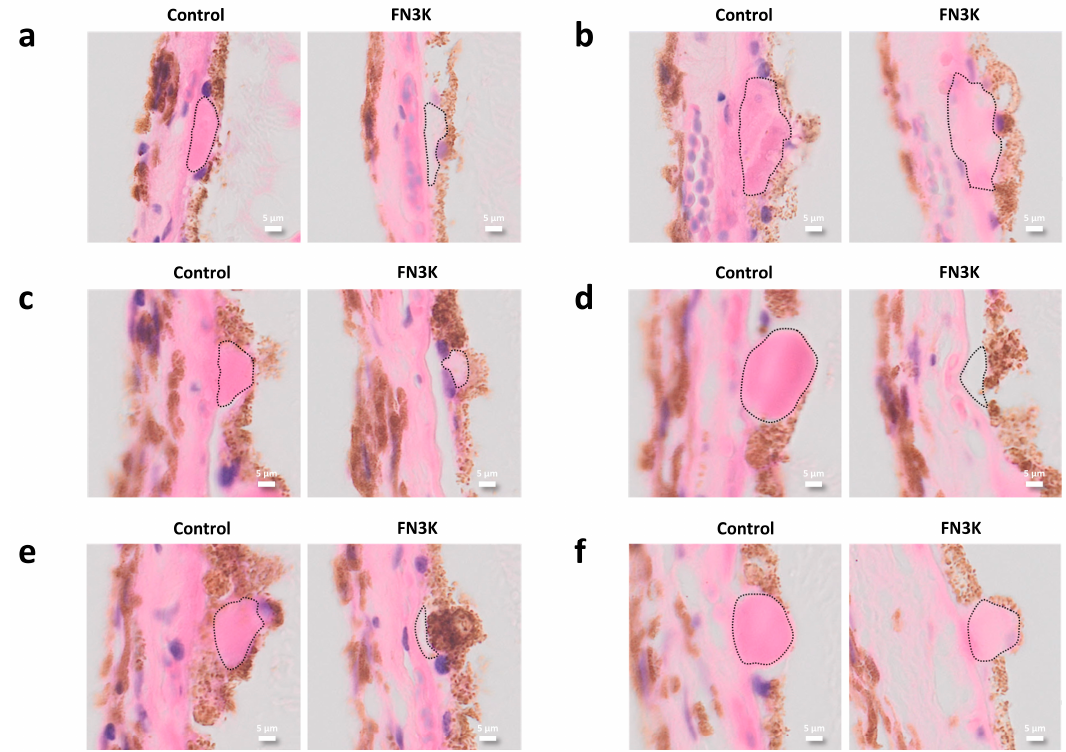
Figure 4. ( a – f ) Pairwise comparison on hematoxylin and eosin stained adjacent slides of 6 out of 17 control- and fructosamine-3-kinase (FN3K)-treated drusen originating from two patients with stage 3 AMD. Drusen are delineated with dotted lines. The scale bars are 5 µm.